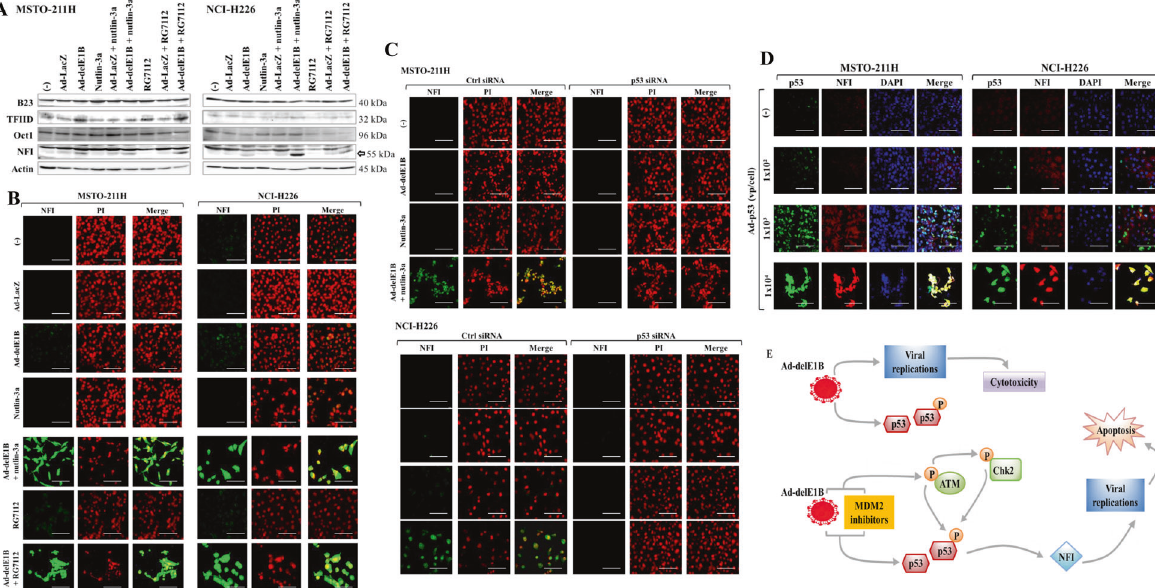
Fig. 6 Enhanced NFI expression with MDM2 inhibitors. Cells were infected with Ad-delE1B or Ad-LacZ (3 × 10 3 vp/cell) for 2 days, and then treated with nutlin-3a (15 µM) or RG7112 (10 µM) for further 16 h in MSTO-211H or 36 h in NCI-H226. A Cell lysate was examined for expression of cellular factors linked with Ad replications with Western blot analysis. NFI: An upper band ubiquitously expressed was non-speci fi c and a lower band corresponding to 55 kDa was authentic. B – D Cells were stained with Ab against NFI or p53, or with DAPI or PI, and the images were analyzed with a laser confocal microscope. C Expression of p53 was knocked down with p53 siRNA and non-target siRNA was used as a control. Cells transfected with siRNA were infected with Ad-delE1B for 2 days, and then treated with nutlin-3a (15 µM) or RG7112 (10 µM) for further 16 h in MSTO-211H or 36 h in NCI-H226. D Cells were infected with several vp of Ad-p53 as indicated for 2 days. E A model of Ad- delE1B and p53 upregulated by MDM2 inhibitors in Ad-mediated cytotoxicity and virus replications. Scale bar: 10 μ